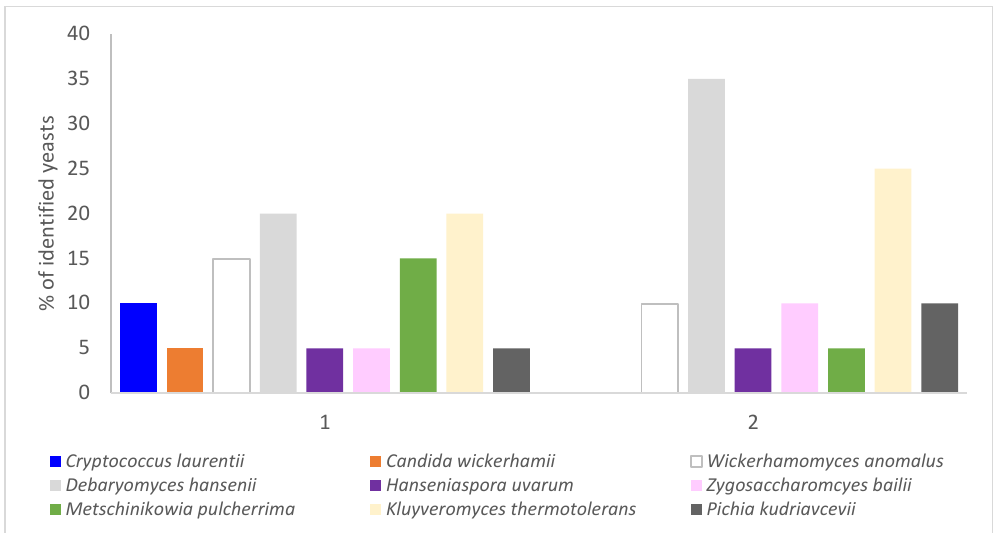
Figure 1. Percentage of yeast isolates from non-treated (control must) and microwave-treated musts (1 and 2, respectively).